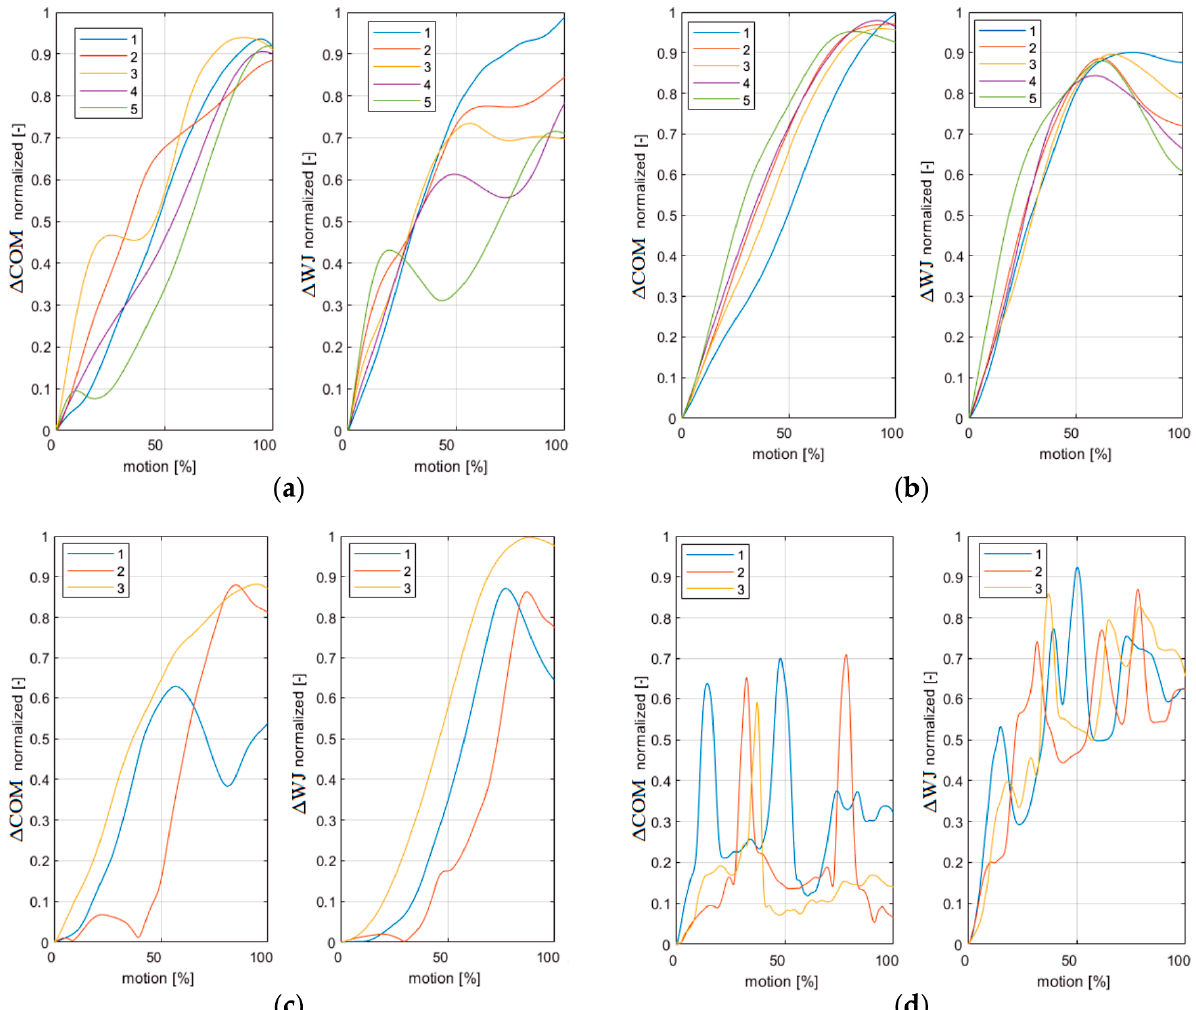
Figure 3. ( a ) Reference subject in motion1 under natural conditions; ( b ) Reference subject in motion1 under passive manipulator conditions; ( c ) DMD subject in motion1 under natural conditions; ( d ) DMD subject in motion1 under passive manipulator conditions.